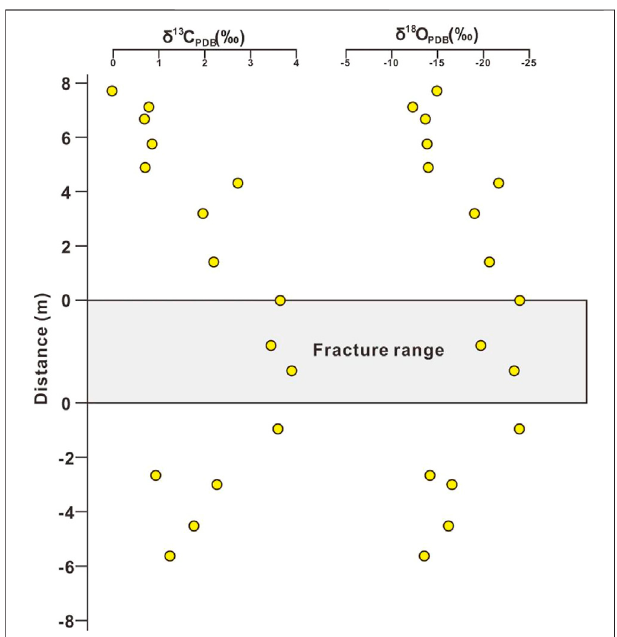
FIGURE 9 | Evolution of carbon and oxygen isotopes of dolomite cements at different ranges from fractures.